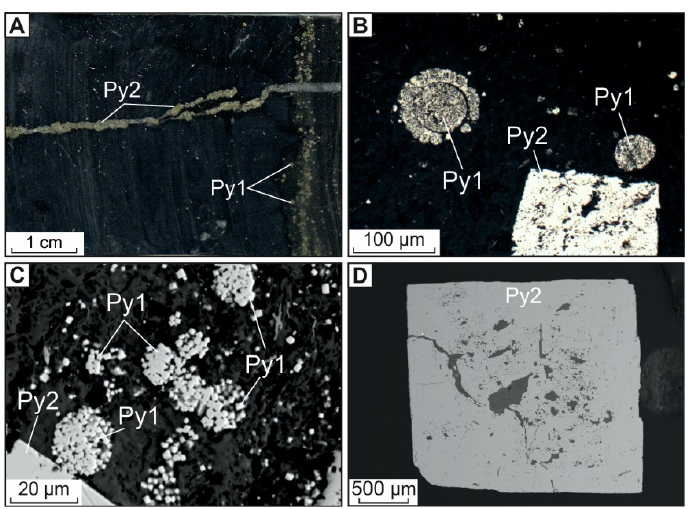
Figure 5. ( A ) Photo and ( B ) photomicrographs of Py1 and Py2 of Khangalas deposit in reflected light , and ( C,D ) backscattered electrons: ( A ) Py2 veinlets and Py1 bedding-plane dissemination in siltstone; ( B , C ) diagenetic Py1 and metamorphic Py2; ( D ) metamorphic Py2.